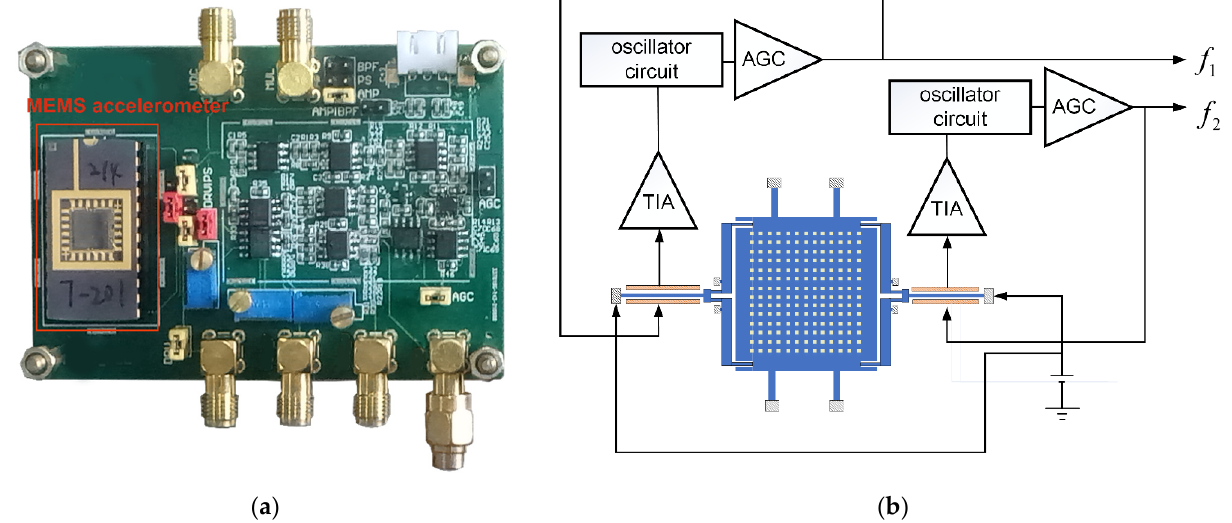
Figure 4. ( a ) Photograph of driving circuit PCB (Printed Circuit Board) and packaged accelerometer. ( b ) Schematic of driving circuit.